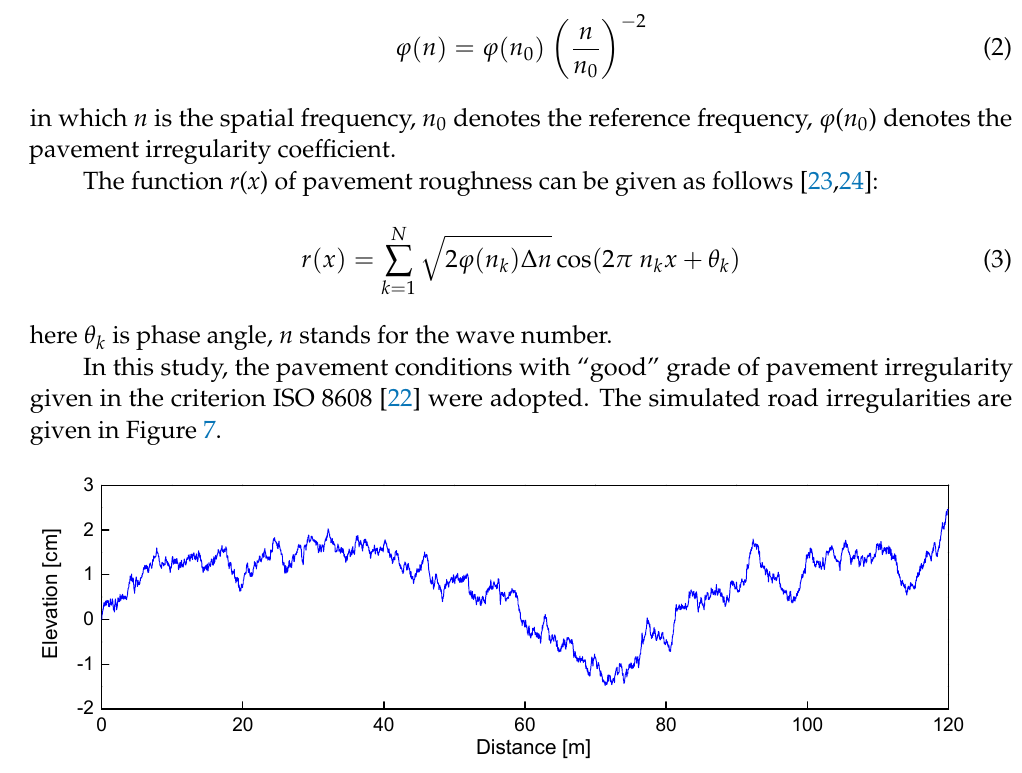
Figure 7. Simulated road irregularities in this study.